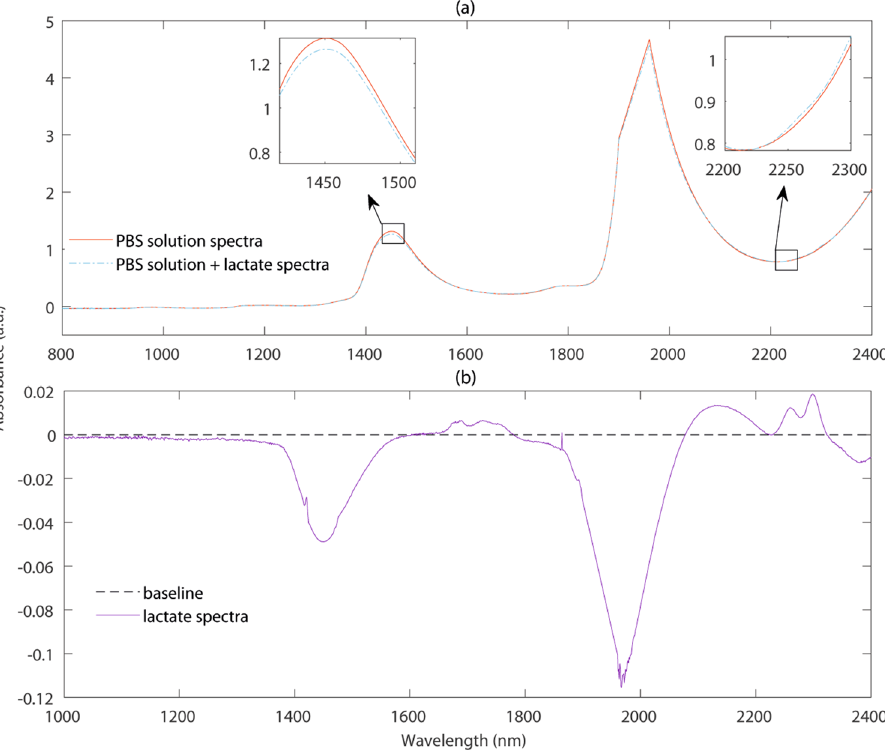
Figure 1. ( a ) The raw spectra of sodium l-lactate dissolved in aqueous PBS (concentration: 100 mmol/L) along with the spectra of just the aqueous PBS solution in the SWIR optical window. ( b ) Resultant spectra following the subtraction of aqueous PBS spectra from the lactate containing